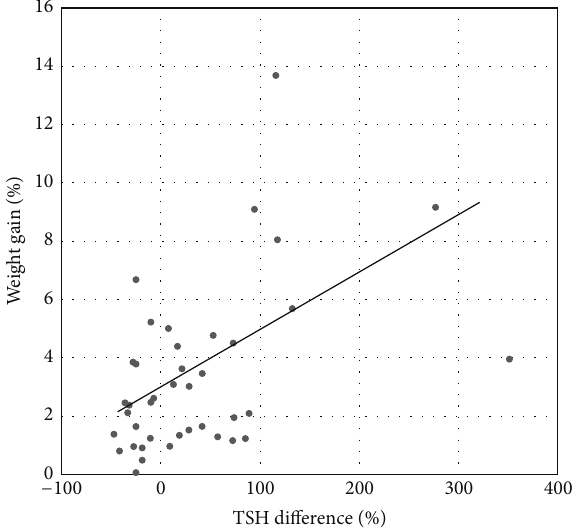
Figure 3: Correlation between relative changes in weight and serum TSH. Correlation between percent increase in weight and percent change in serum TSH of the hemithyroidectomy group ( 𝑛 = 18 ) and the control group ( 𝑛 = 22 ) during the follow-up period ( 𝑟 = 0.43 , 𝑃 < 0.01